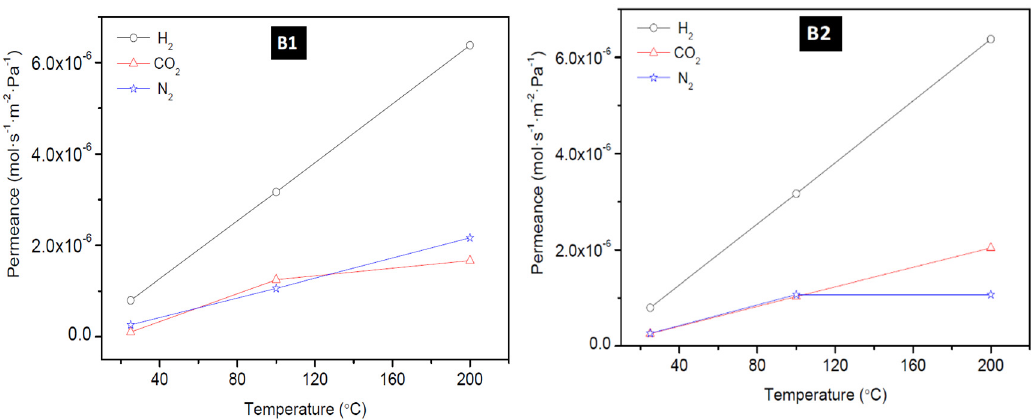
Figure 8. Effect of permeation temperature on H 2 , CO 2 , and N 2 permeance of membrane B1 and